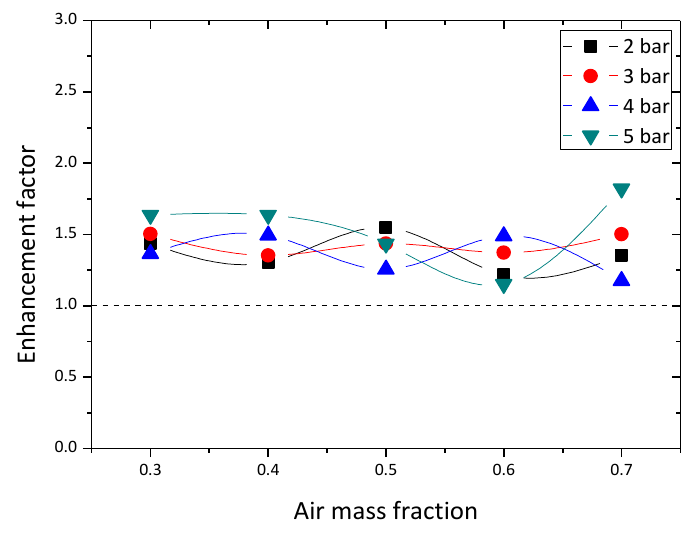
Figure 12. Enhancement factor along the air mass fraction at 2, 3, 4, and 5 pressure.